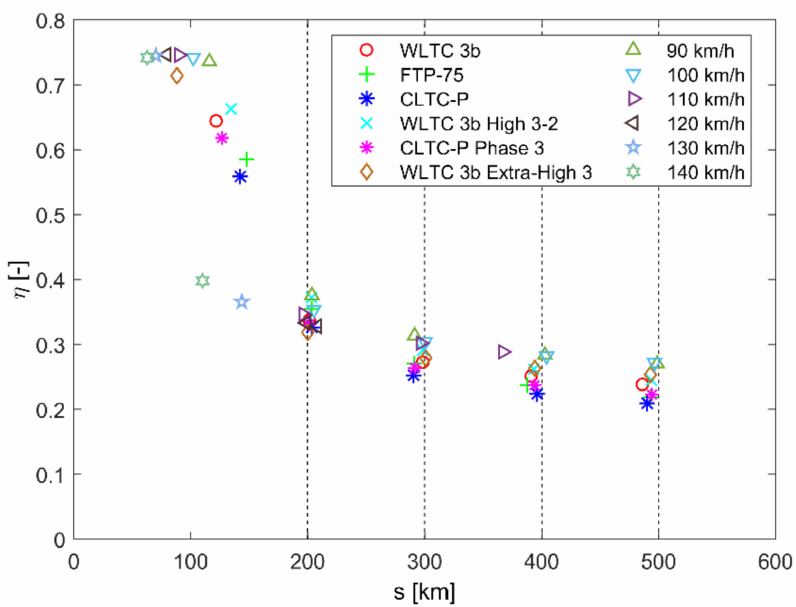
Figure 16. Efficiency results for BEV mode and EREV drive (four EREV range targets indicated with dashed vertical lines) in various drive cycle conditions. Vehicle mass is equal to 1500